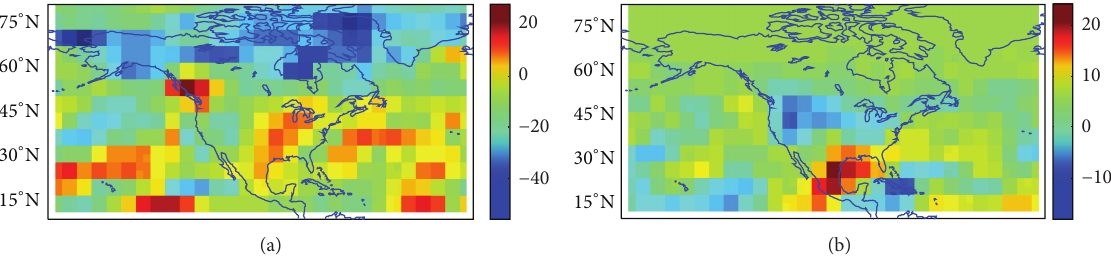
Figure 4: (a) The trend of the downward shortwave radiation at the surface for July from the MRI CGCM2.3.2a simulations. (b) The same as (a) but for January. The trend is defined as the 2080–2100 mean climatology minus the 1980–2000 climatology. Color scales with units of W/m 2 are shown on the right.